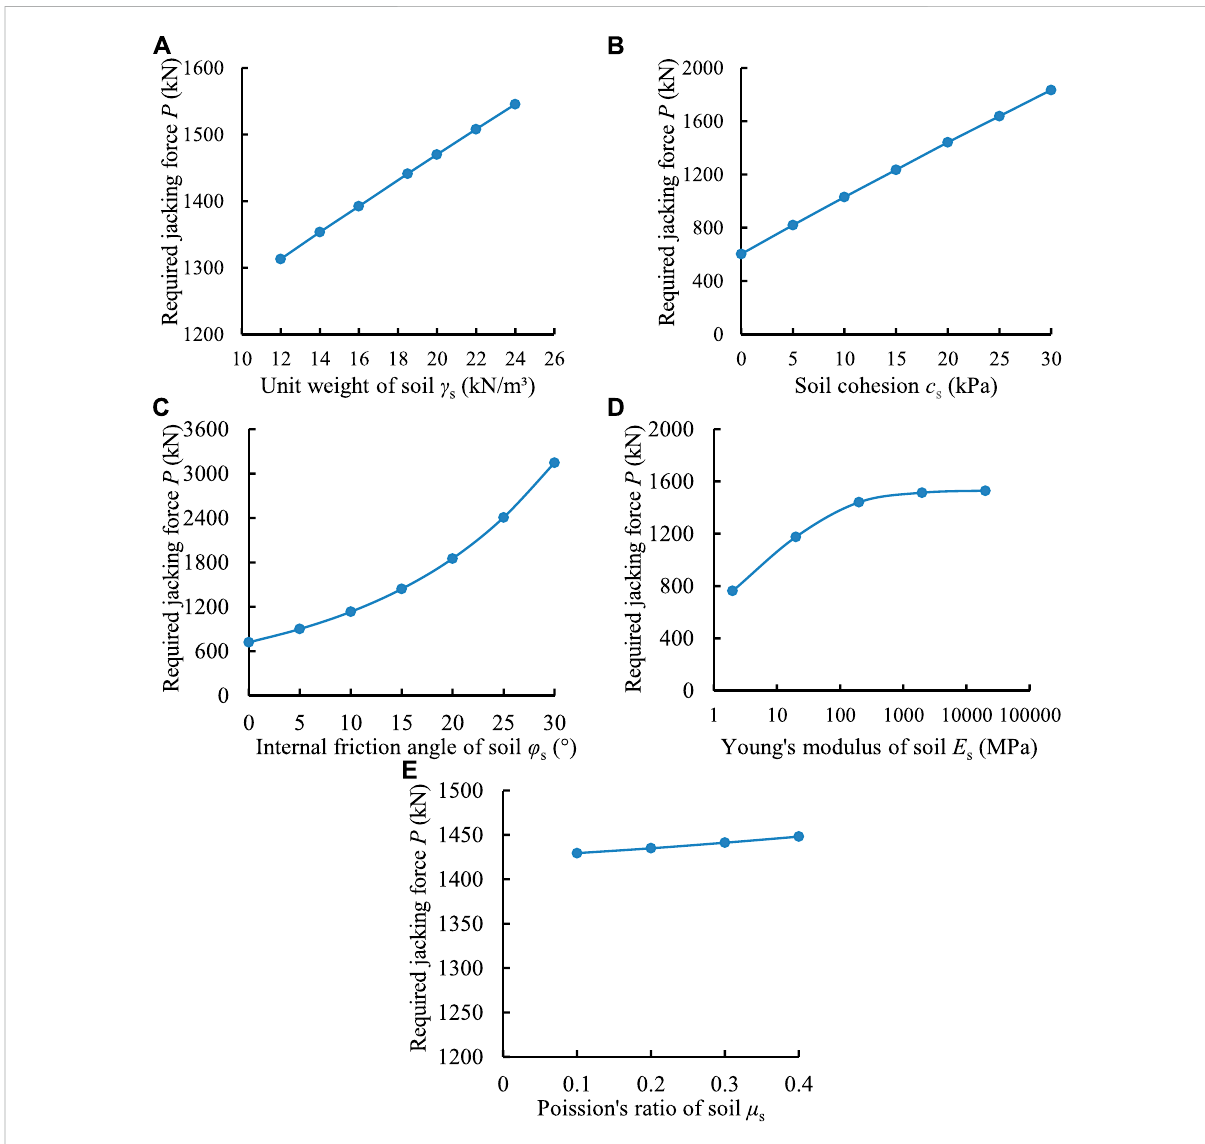
FIGURE 11 Variations of the required horizontal force P with soil properties: (A) Unit weight of soil γ s (Case 4), (B) soil cohesion c s (Case 5), (C) internal friction angle of soil φ s (Case 6), (D) Young ’ s modulus of soil E s (Case 7) and (E) Poisson ’ s ratio of soil μ s (Case